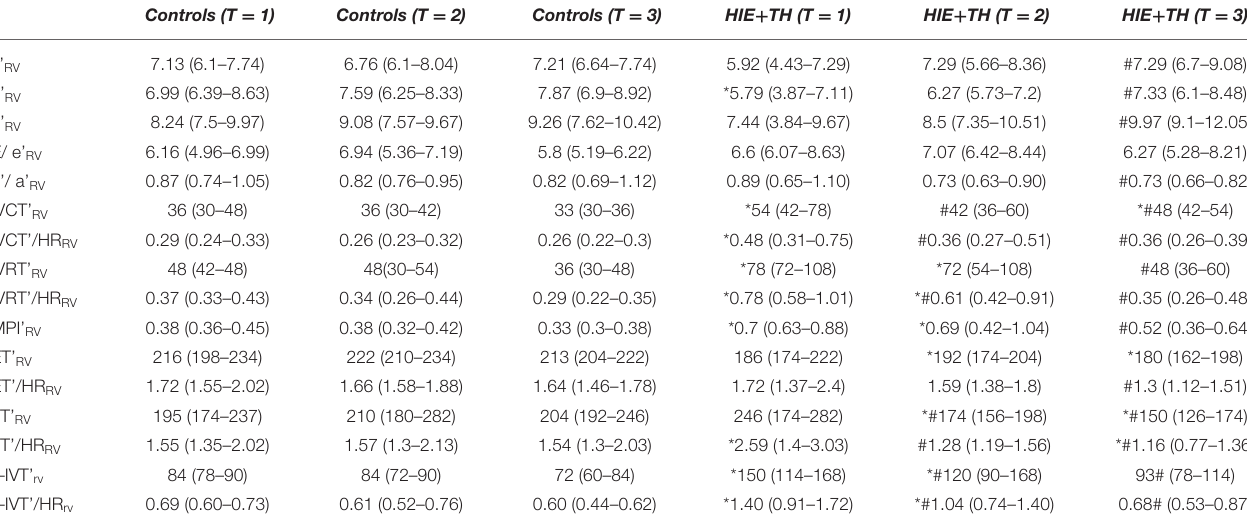
TABLE 5 | TDI data from the right